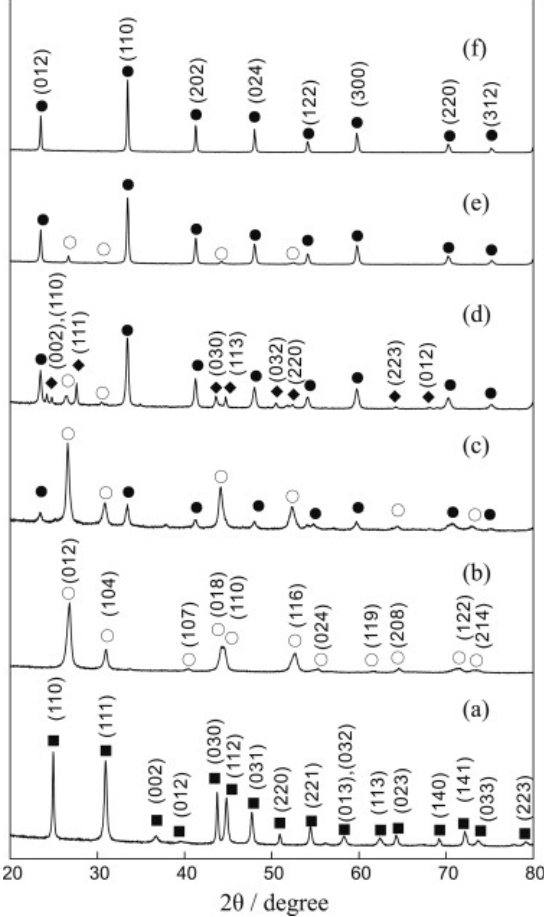
Figure 9. XRD patterns of powders obtained by the calcination of ( a ) a mixture of LaFCO 3 and α - Al 2 O 3 at ( b ) 800 °C, ( c ) 850 °C, ( d ) 900 °C, ( e ) 1000 °C, and ( f ) 1100 °C for 5 h under an air atmosphere.